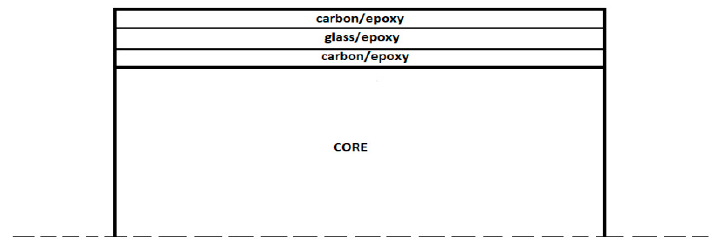
Figure 2. A scheme of the architecture of the tested sandwich panels (not on scale). Two sandwich specimens were impacted by an 8J energy impactor by using an In- stron/Dynatup impact machine (Instron, High Wycombe, Buckinghamshire, UK). They were held by a fixture which has an unsupported window (75 × 125 mm) directly under the impactor. The impactor head had a semi-spherical shape of 16 mm diameter. The (0 ◦ ) fiber direction was aligned with the length of the window. The frame of the test machine configuration is given in Figure 3.